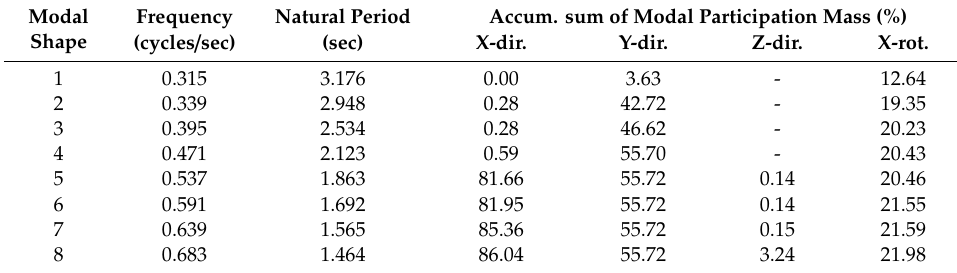
Figure 8. Mode shape configurations using e ff ective sti ff ness (K e ff ). Table 5. Mode shape result using primary sti ff ness (K u ).